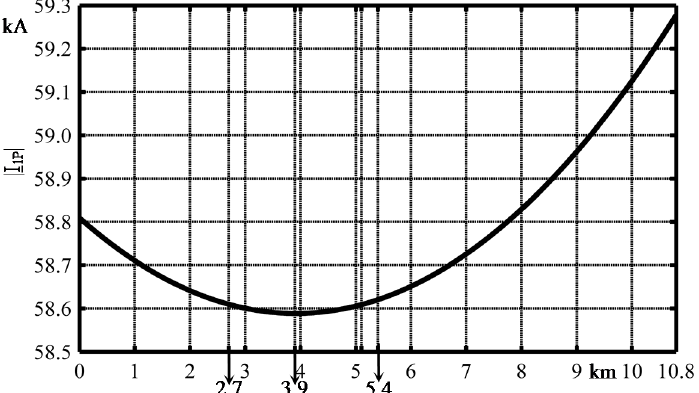
Figure 18. Phase-to-screen short circuit current magnitude along line in a single circuit UGC.